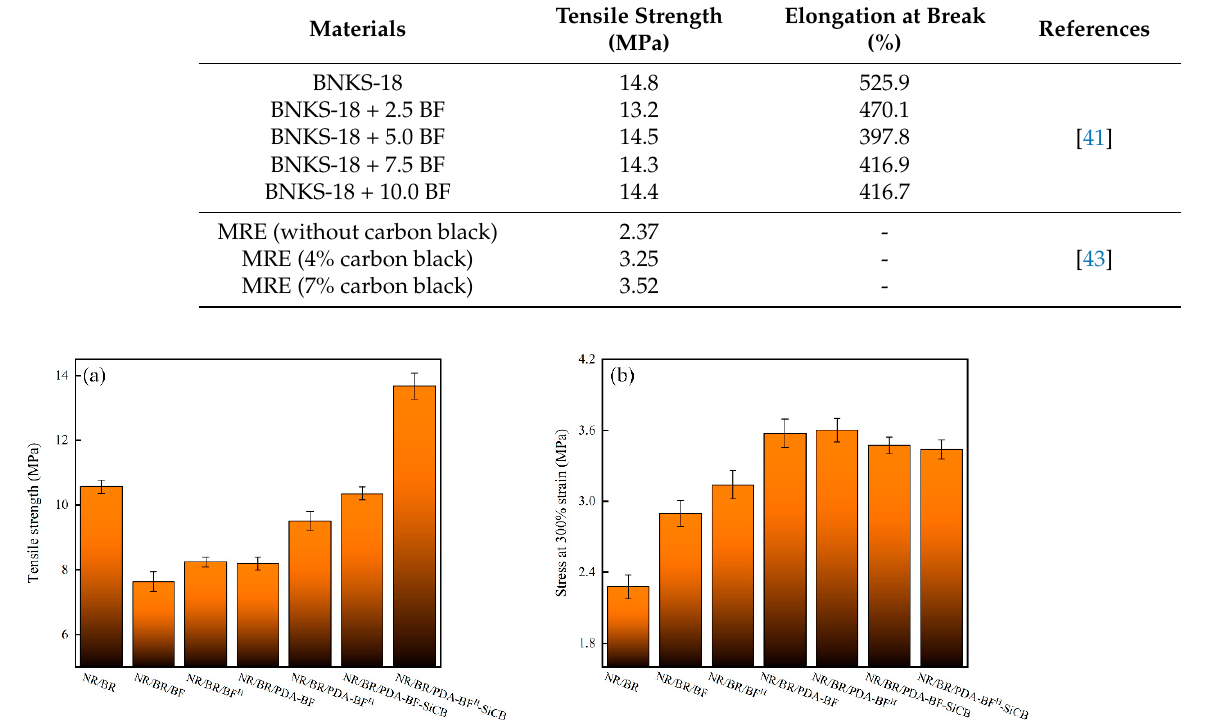
Figure 9. Tensile strength diagram ( a ) and Stress at 300% strain diagram ( b ) of each group of MREs.